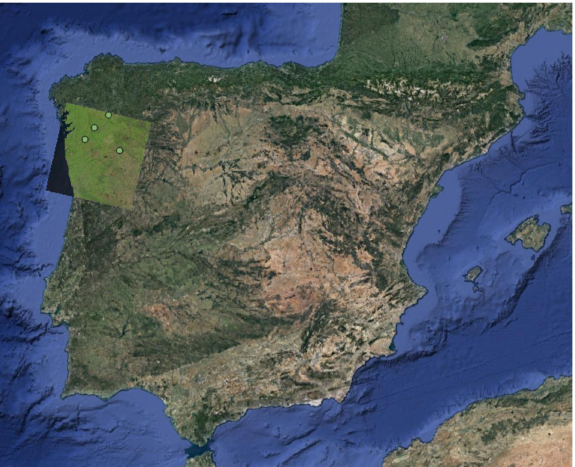
Figure 1. Location of the Landsat imagery and commercial vineyards in Galicia